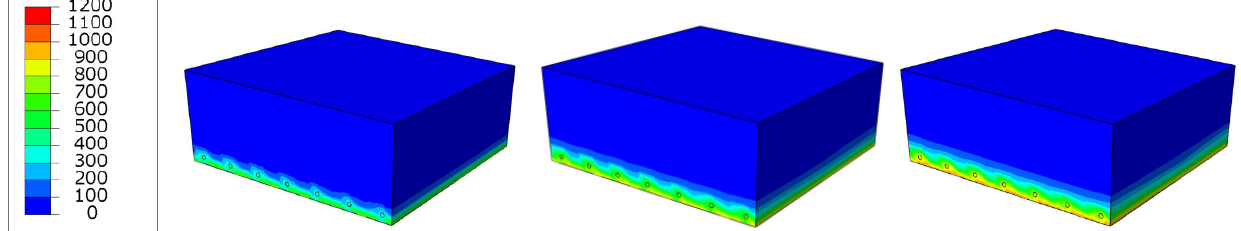
Figure 10. Temperature curve of the solid slab after 90 min fire exposure with dimensions based on [5,6].